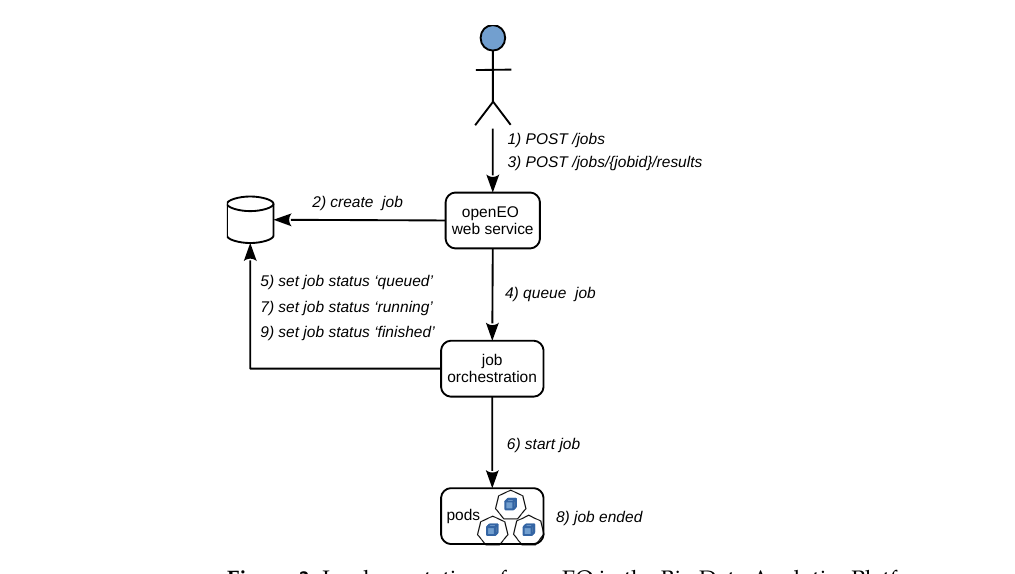
Figure 3. Implementation of openEO in the Big Data Analytics